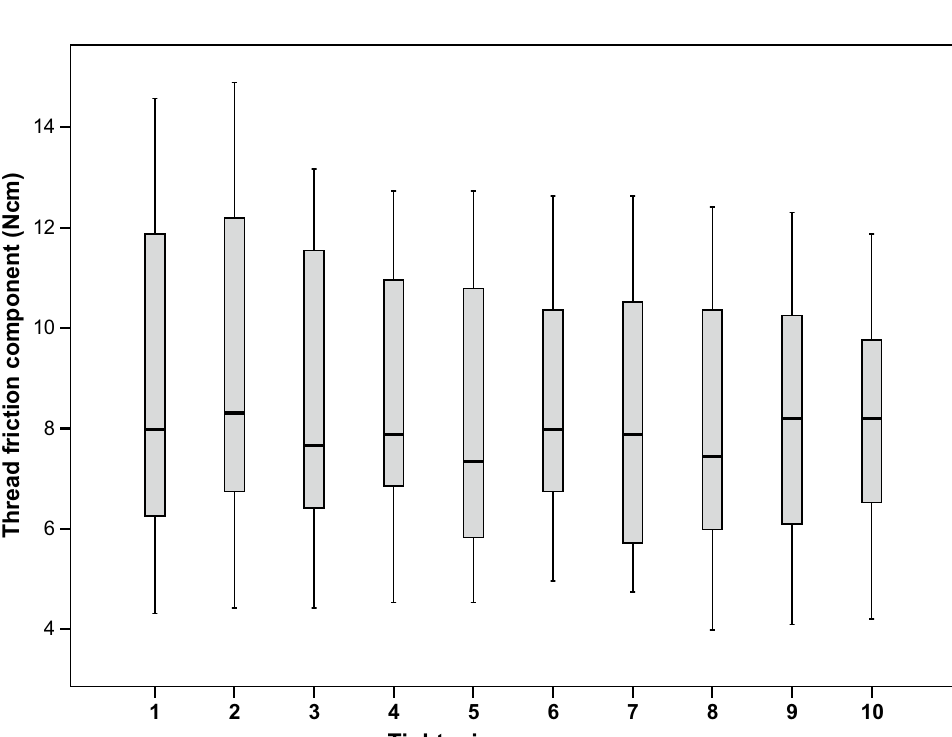
Fig. 7 Distribution of the thread‑friction component of the tightening torque by tightening